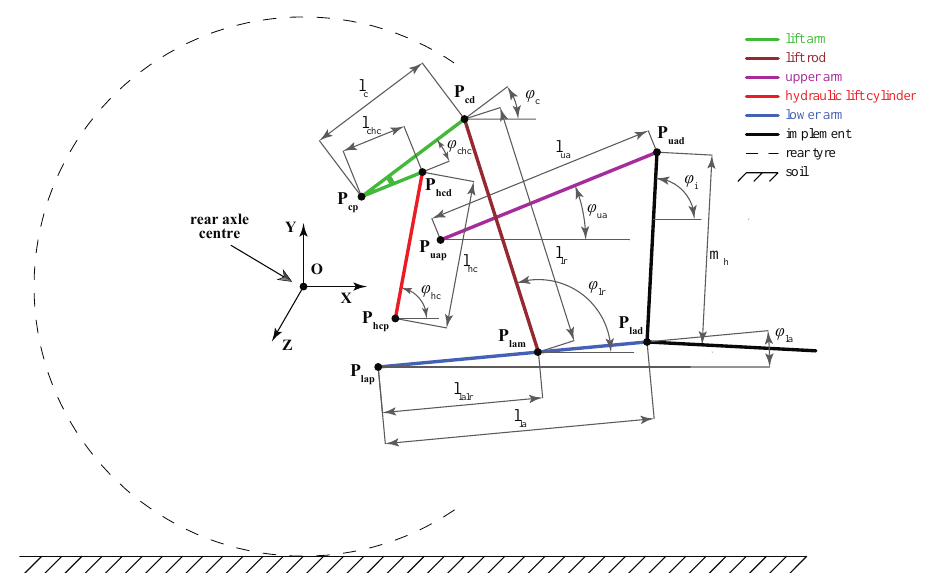
Figure 2. Side view of the TPH and schematic of the implement.